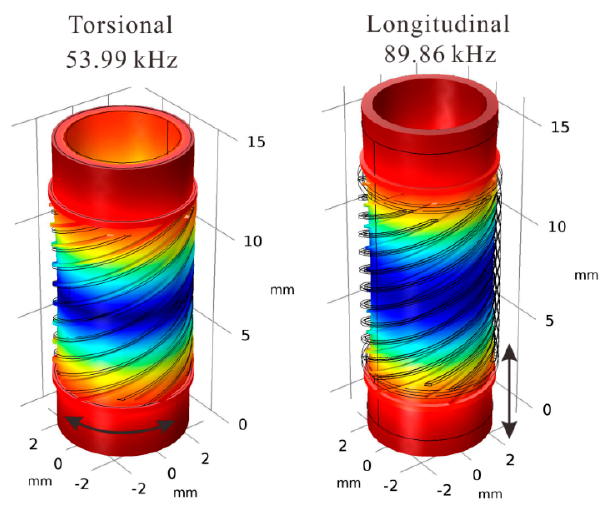
Figure 4. FEM analysis results of PA.